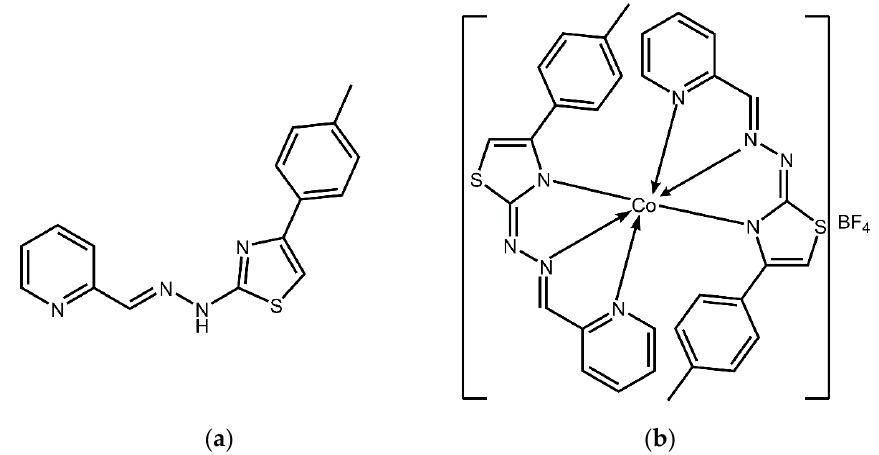
Table 1. Minimum inhibitory (MIC) and minimum bactericidal (MBC) concentrations values